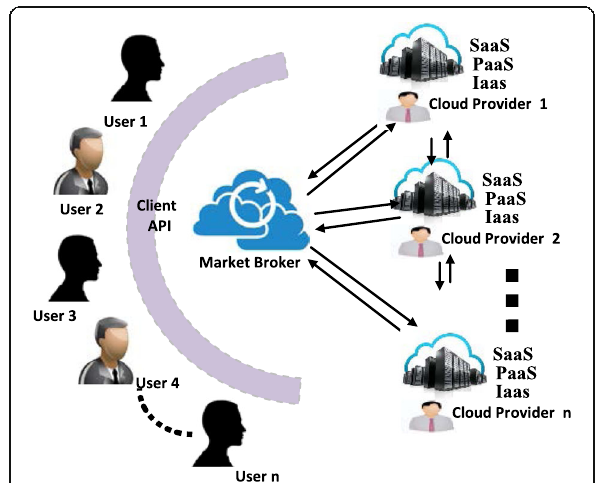
Fig. 1 Schematic Representation of the cooperative cloud